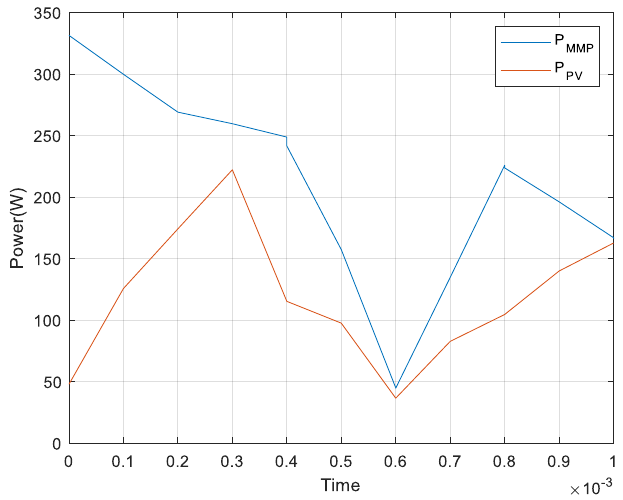
Figure 11. PV testing of the optimization algorithm..